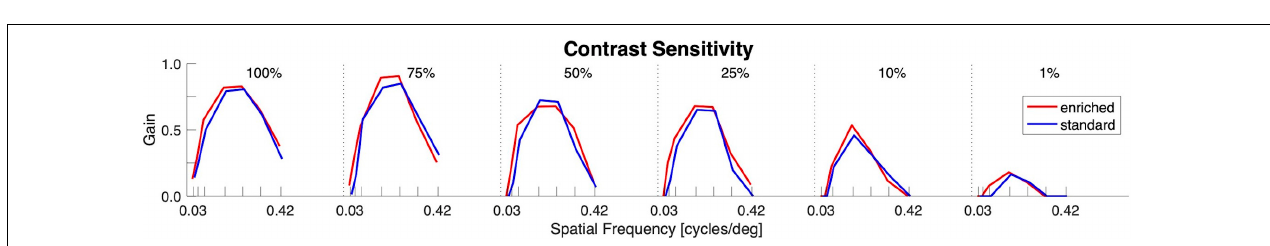
FIGURE 3 | Visual functioning (Contrast Sensitivity). OKR gain as function of spatial frequency for different levels of contrast. No differences between the enriched (red) and standard (blue) housed groups could be observed.